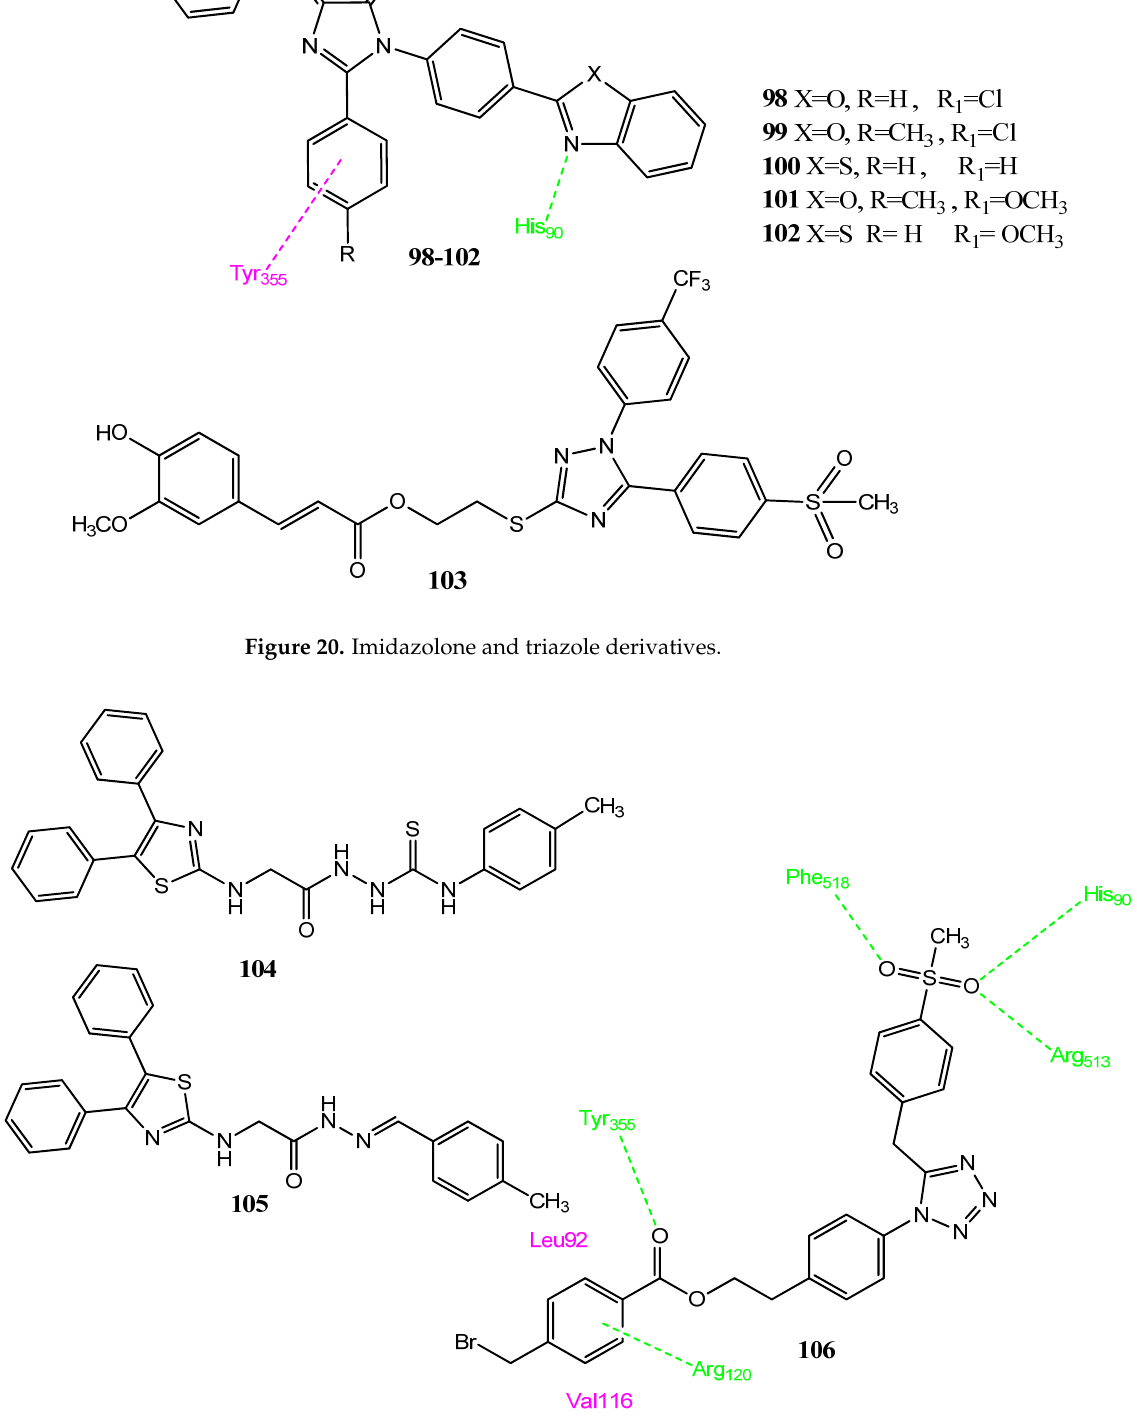
Figure 21. Thiazole and tetrazole derivatives.